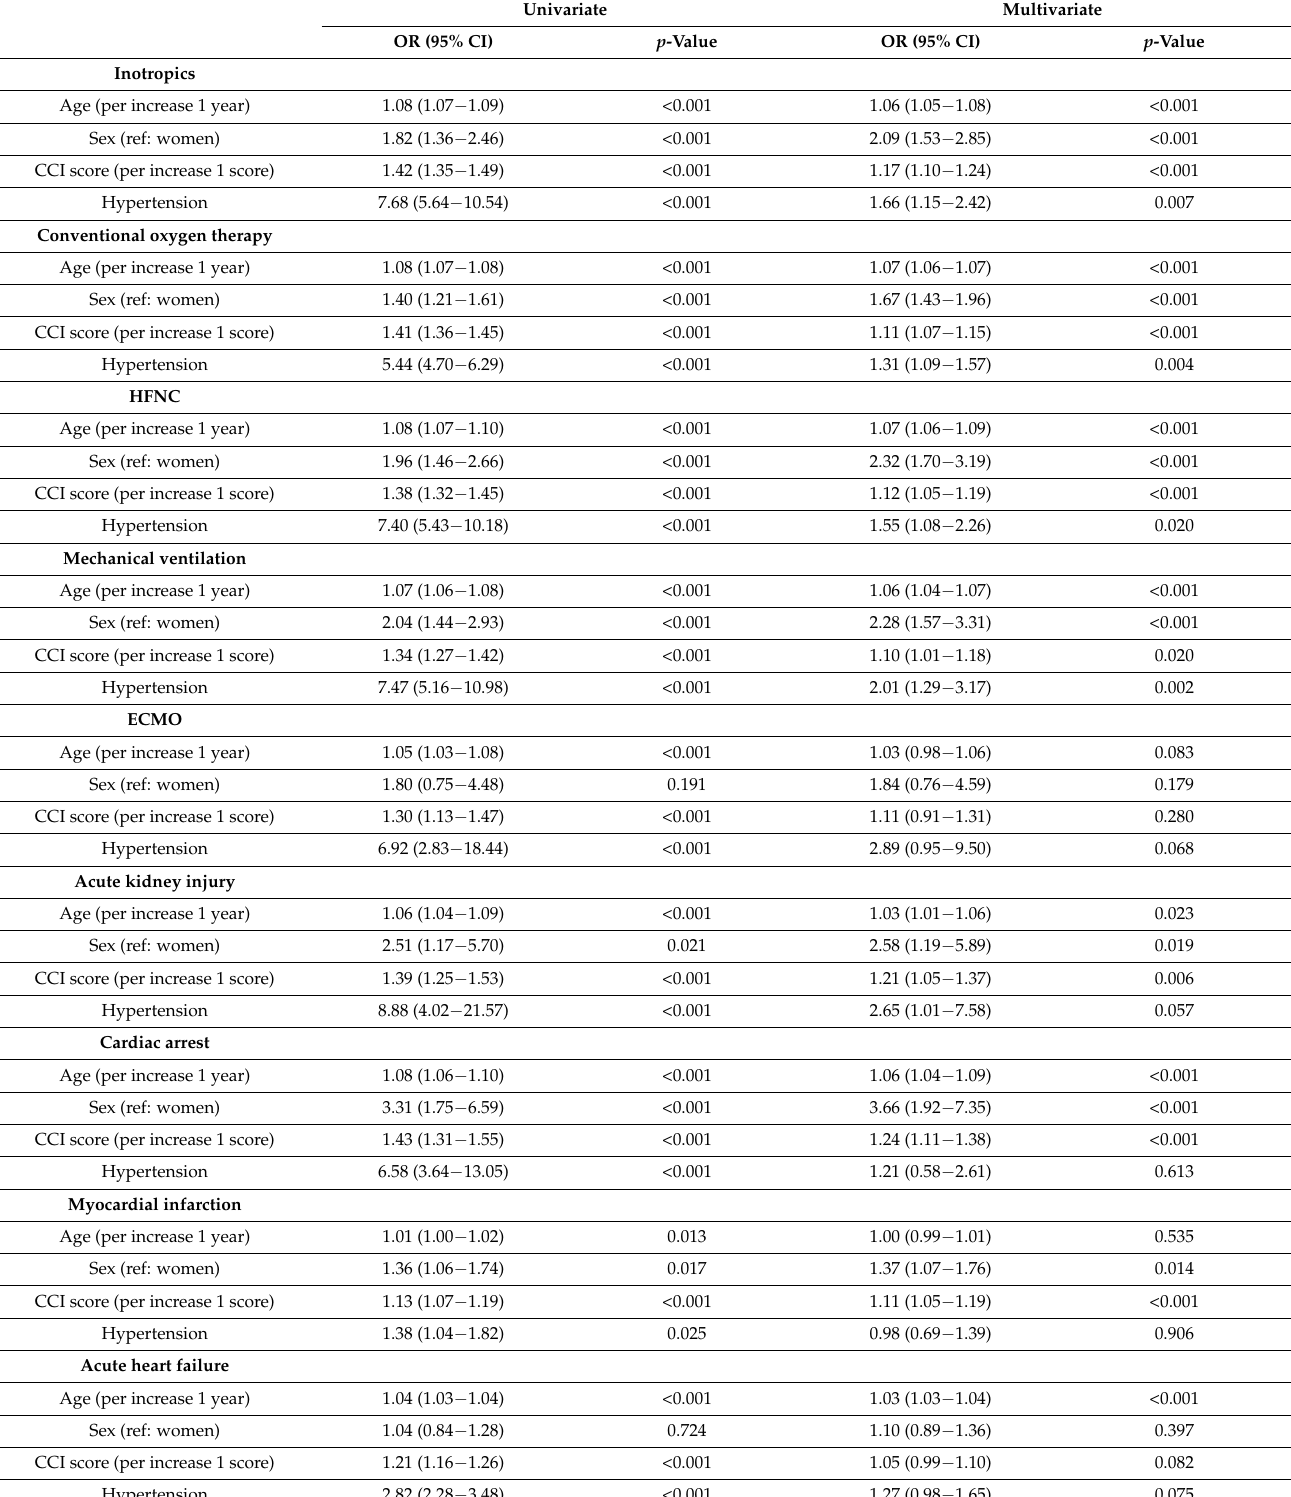
Table 4. Logistic regression analysis of the clinical outcomes according to